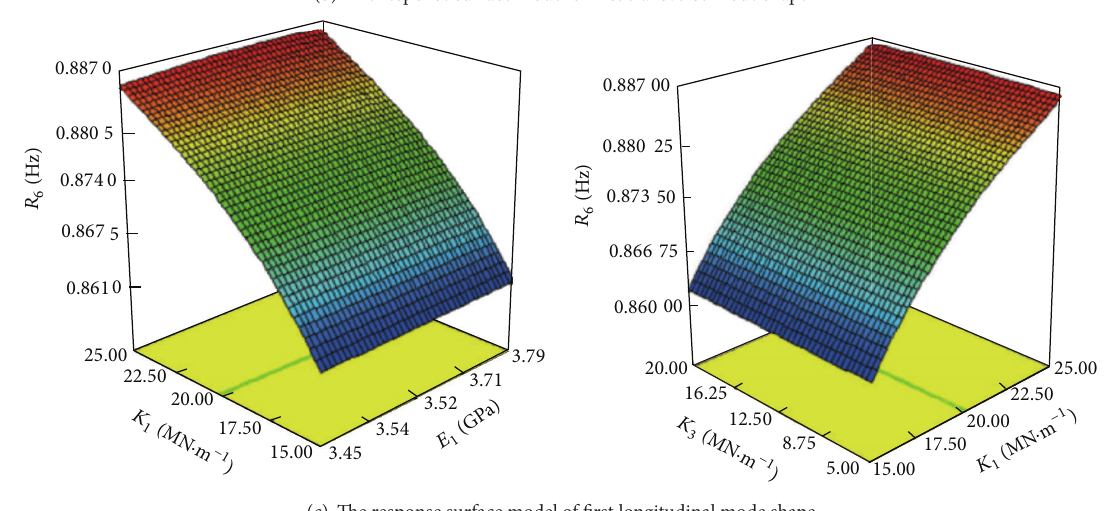
(b) The response surface model of first transverse mode shape